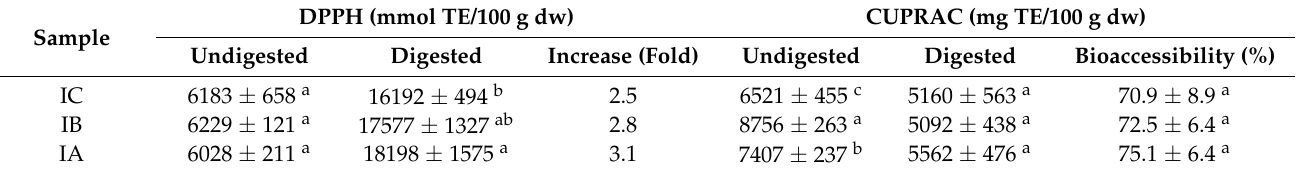
Table 3. Changes in the antioxidant potential of infusion phenolics throughout in vitro gastrointestinal